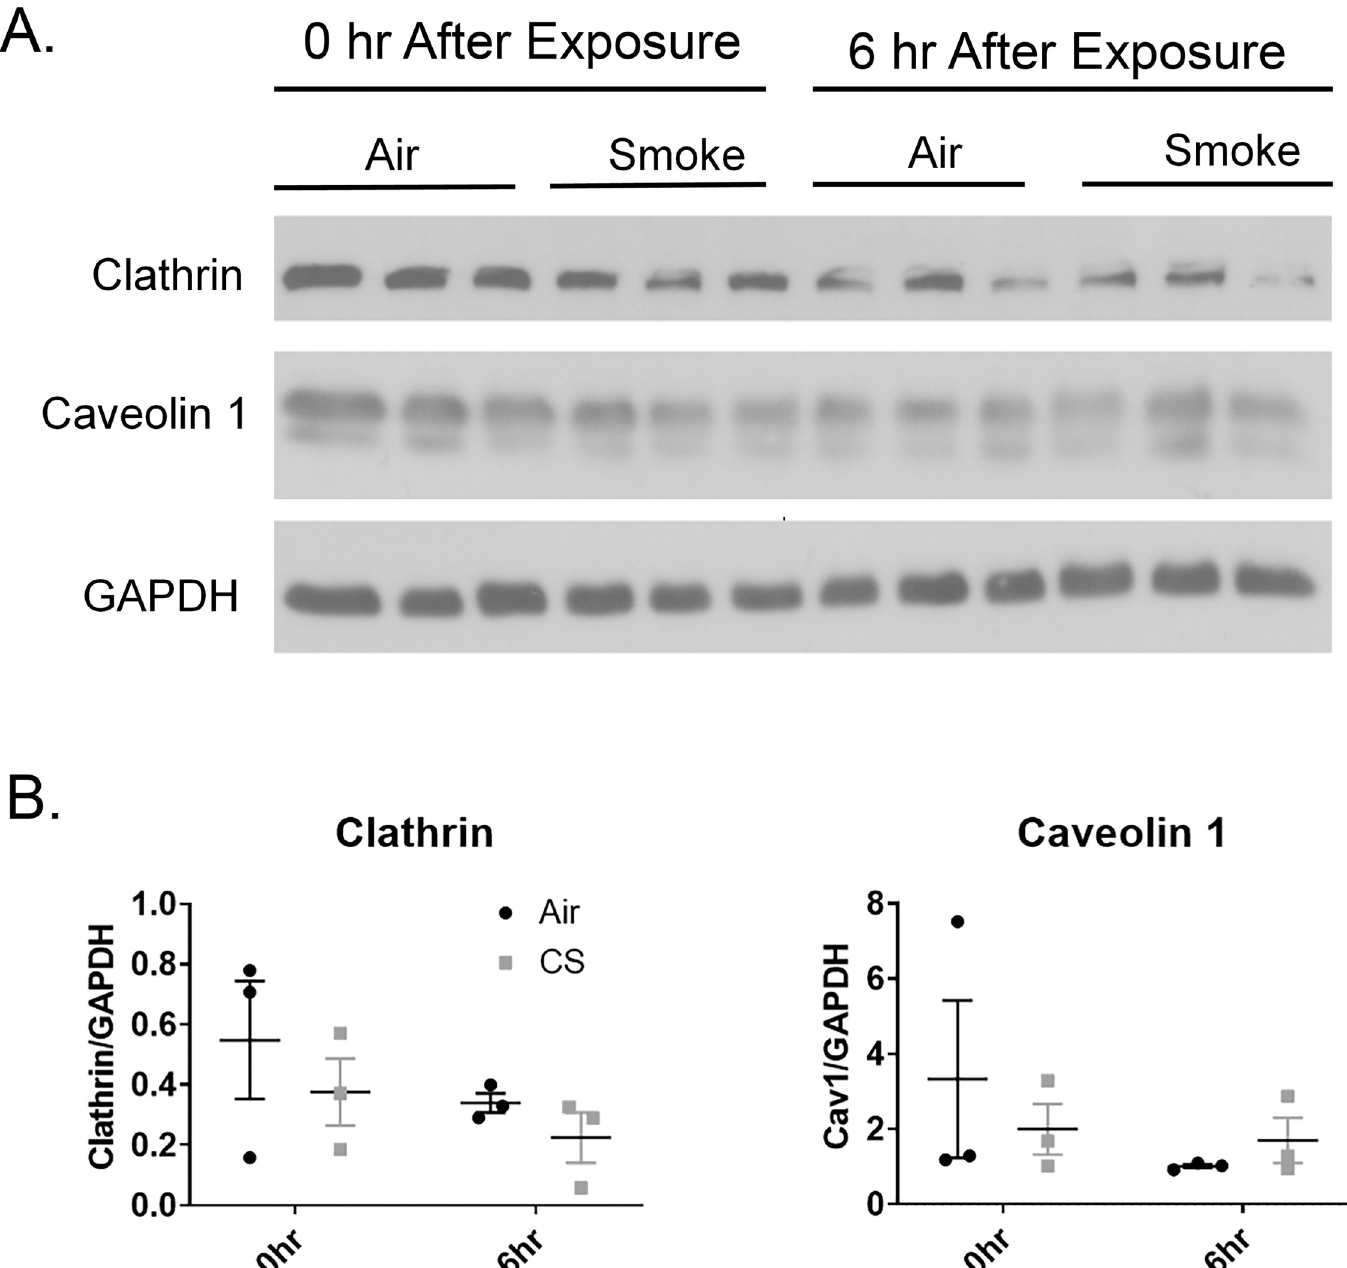
Fig 6. Cigarette smoke does not alter protein levels of clathrin or caveolin. (A) Primary human SAEC were exposed to either air or cigarette smoke for 60 minutes at the air-liquid interface. Cells were lysed immediately following smoke exposure or 6 hours post-smoke exposure and whole-cell levels of clathrin and caveolin were determined by Western Blot. (B) Caveolin and clathrin expression was quantified using densitometry normalized to GAPDH. No significant differences in expression were identified. infected cells was determined by immunofluorescent staining for the NP protein. Similar to poly I:C and the caveolin pathway, smoke-exposed SAECs had an increased viral protein expression indicating increased infectivity and propagation (Fig 7A). IAV has been shown in many susceptible lines to be taken up by CME which is in contrast to our finding of increased